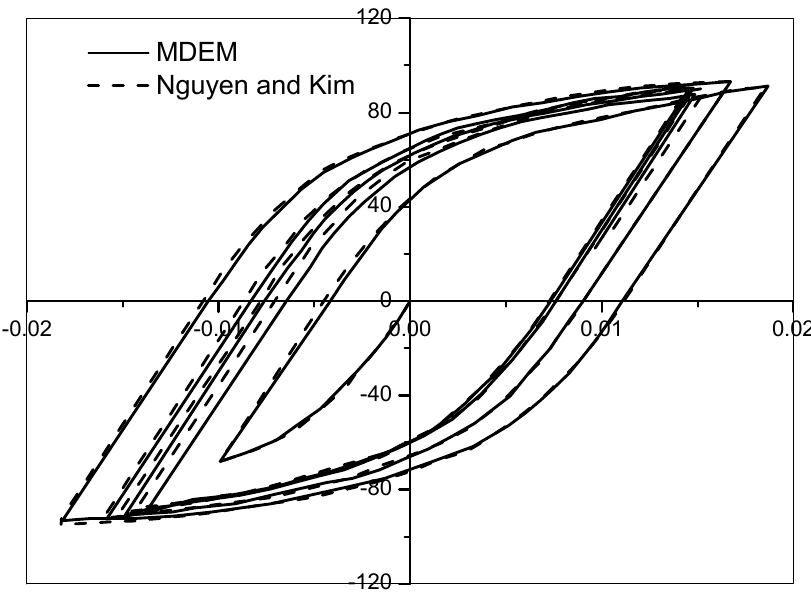
Figure 23. Hysteresis loops at the semi-rigid connection G.